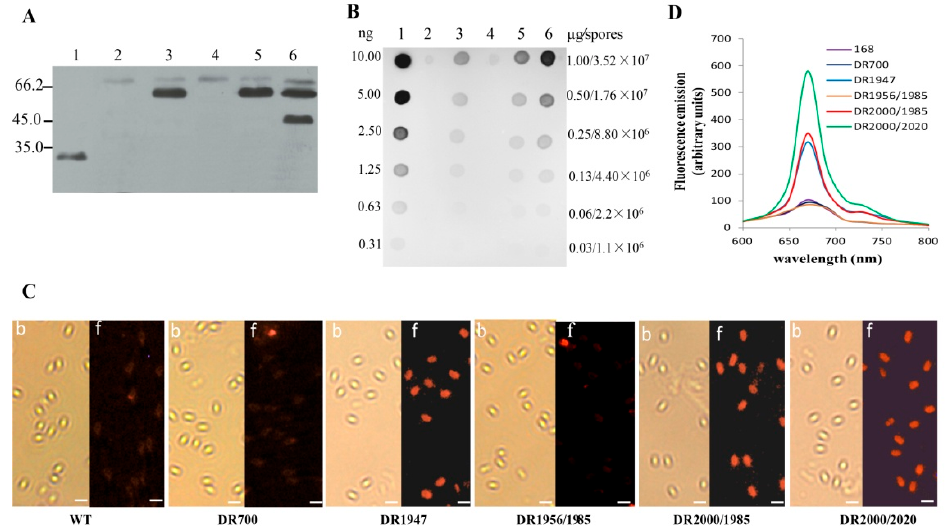
Figure 2. Detection of the Vp7 antigen in the recombinant B. subtilis spores. ( A ) Western blot analysis of the Vp7 antigen in the spore coat proteins. Lane 1, the purified His 6 -Vp28; lanes 2–6, the coat proteins extracted from the spores of the recombinant strains DR700, DR1947, DR1956 / 1985, DR2000 / 1985, and DR2000 / 2020, respectively. Molecular weight markers (kDa) are indicated at the right. ( B ) Dot blot analysis for the amount of the Vp7 antigen in the recombinant spore coat. The amounts of His 6 -Vp7 (lane 1) and the coat proteins from the spores of DR700 (lane 2), DR1947 (lane 3), DR1956 / 1985 (lane 4), DR2000 / 1985 (lane 5), and DR2000 / 2020 (lane 6) were indicated. ( C ) Immunofluorescent detection of the Vp7 antigen on the spore surface. The immunofluorescence-labeled spores were visualized under bright field (b) and fluorescence (f) microscopy. Scale bars indicate 1 µ m. ( D ) Quantitative analysis of the Cy5 fluorescence on the spore surface with fluorospectrophotometer.